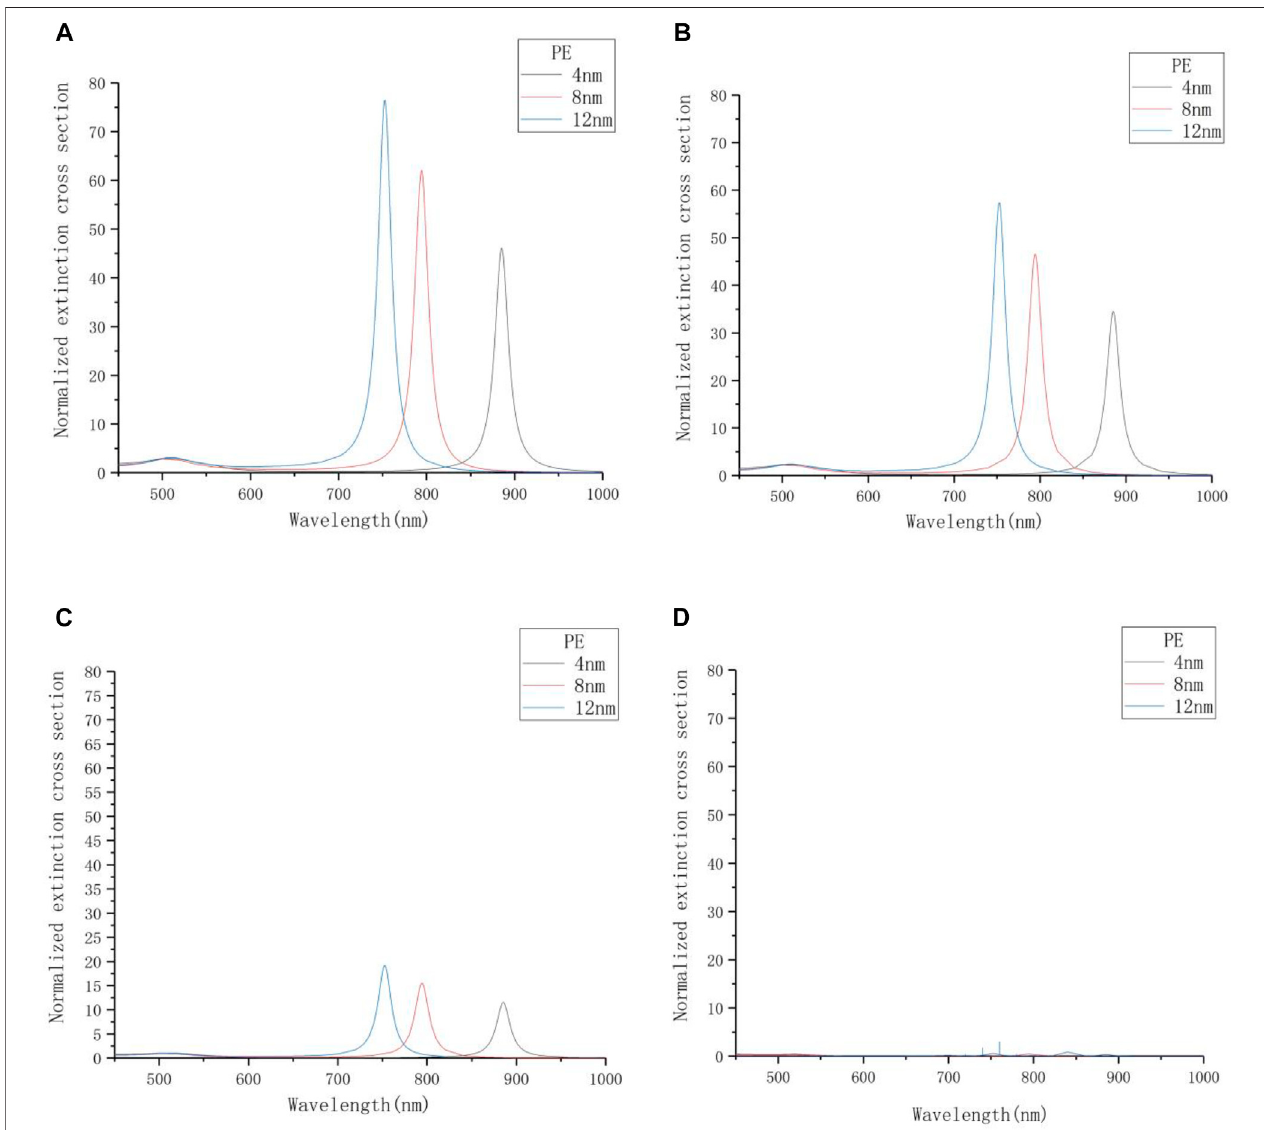
FIGURE 3 | The extinction spectrum with different azimuth angles. (A) φ (cid:1) 0 ° . (B) φ (cid:1) 30 ° . (C) φ (cid:1) 60 ° . (D) φ (cid:1) 85 ° .